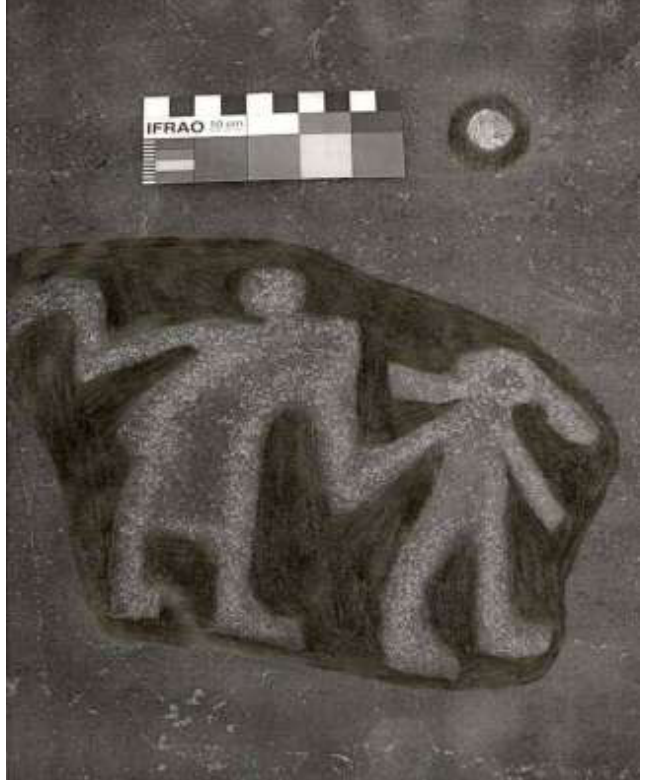
Figure 13. Saral, Afrasiw village, a pattern of two